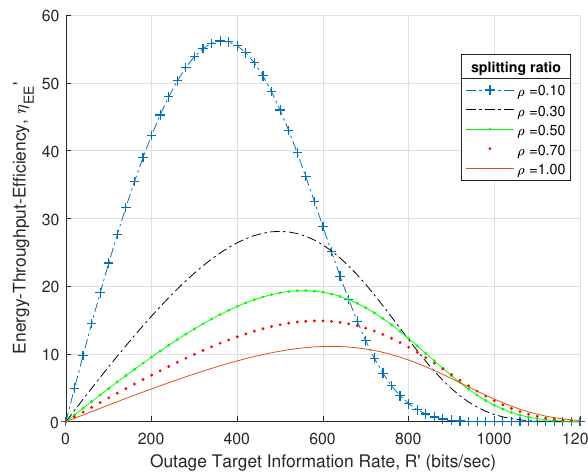
Figure 8. EE vs. outage information rate in PS mode.